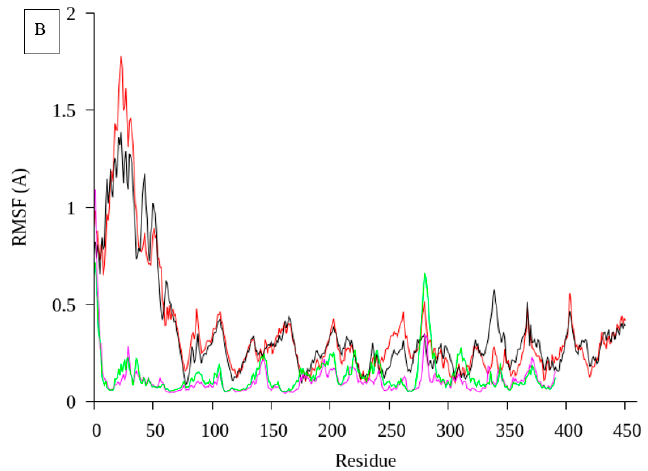
Figure 5. Molecular dynamic simulation of truncated AMS3 lipase at 20 and 30 °C. ( A ): RMSD value for truncated AMS3 lipase in 20 ns; ( B ): RMSF value for truncated AMS3 lipase in 20 ns. Color in Red: native in 20 °C; Black: native 30 °C; Green: Truncated AMS3 lipase in 20 °C; Magenta: Truncated in 30 °C.